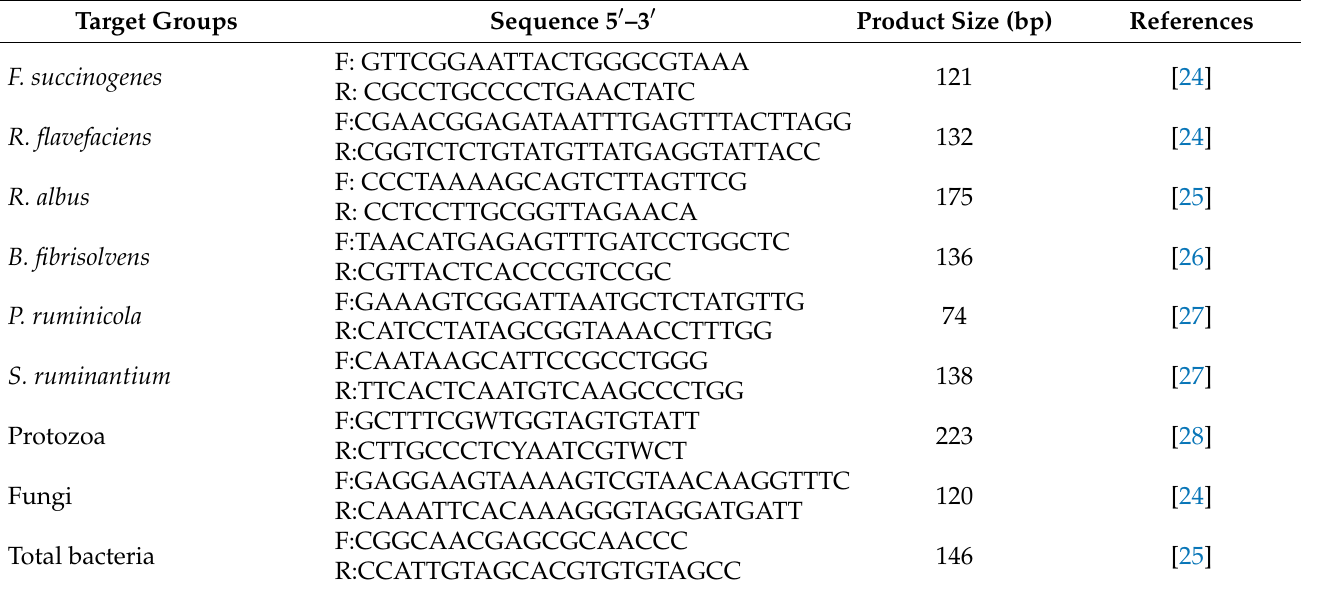
Table 2. Primers for real-time